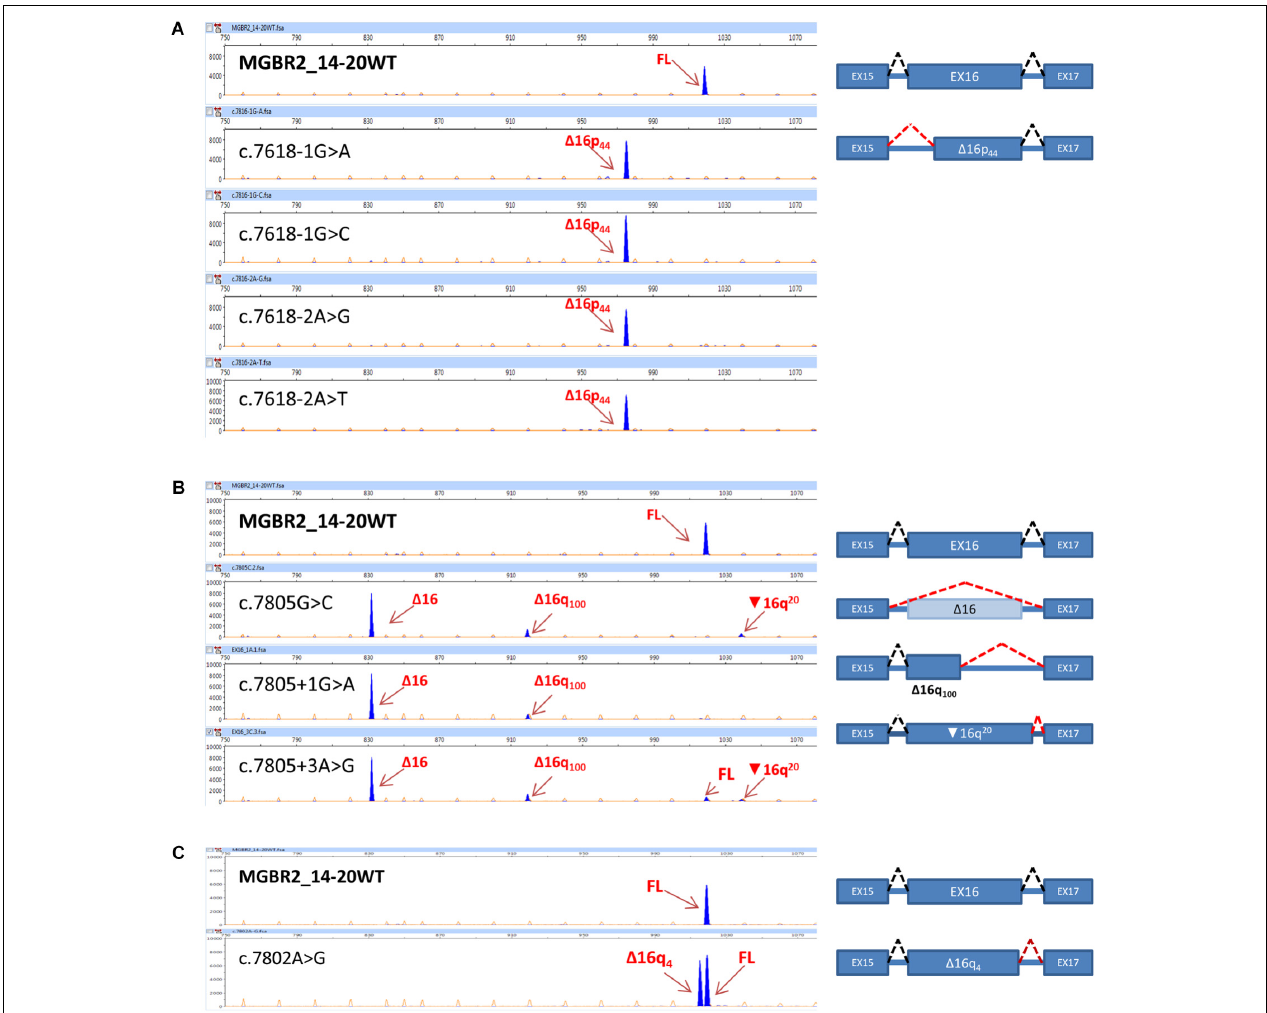
FIGURE 2 | Fluorescent capillary electrophoresis of transcripts from BRCA2 exon 16 variants. On the left, screenshots of electropherograms are shown. cDNA was amplified with primers FAM-labeled pMAD_607FW and RTBR2_ex17RV2. Arrows indicate transcripts (blue peaks). Full-length transcript: 1018 nt. Size standard was Genescan LIZ 1200 (orange/faint peaks). Fragments were analyzed with the Peak Scanner software v1.0. Fragment sizes (bp) and relative fluorescent units are indicated on the x - and y -axes, respectively. On the right, diagrams of the splicing patterns are shown. Boxes represent exons, discontinued black lines represent canonical splicing, and discontinue red lines represent aberrant splicing. (A) Acceptor site variants. (B) Donor site variants. (C) Alternative donor variant.